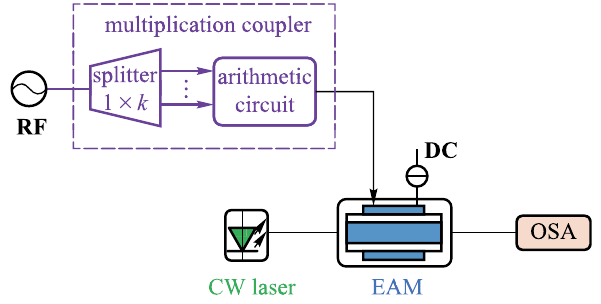
Fig. 1 Schematic diagram of the OFC generation scheme based on a single EAM and a multiplication coupler composed of an electrical power splitter and an arithmetic circuit. RF radio frequency source; splitter electrical power splitter; CW laser continuous wave laser; EAM electro-absorption modulator; DC direct current voltage source; OSA optical spectrum